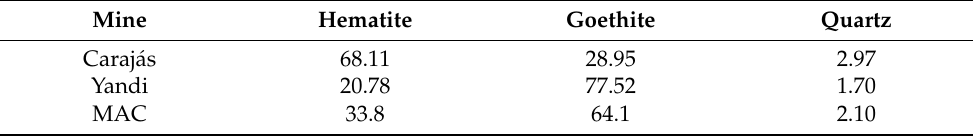
Table 4. Phase fractions of iron ores determined through Rietveld analysis (wt%).